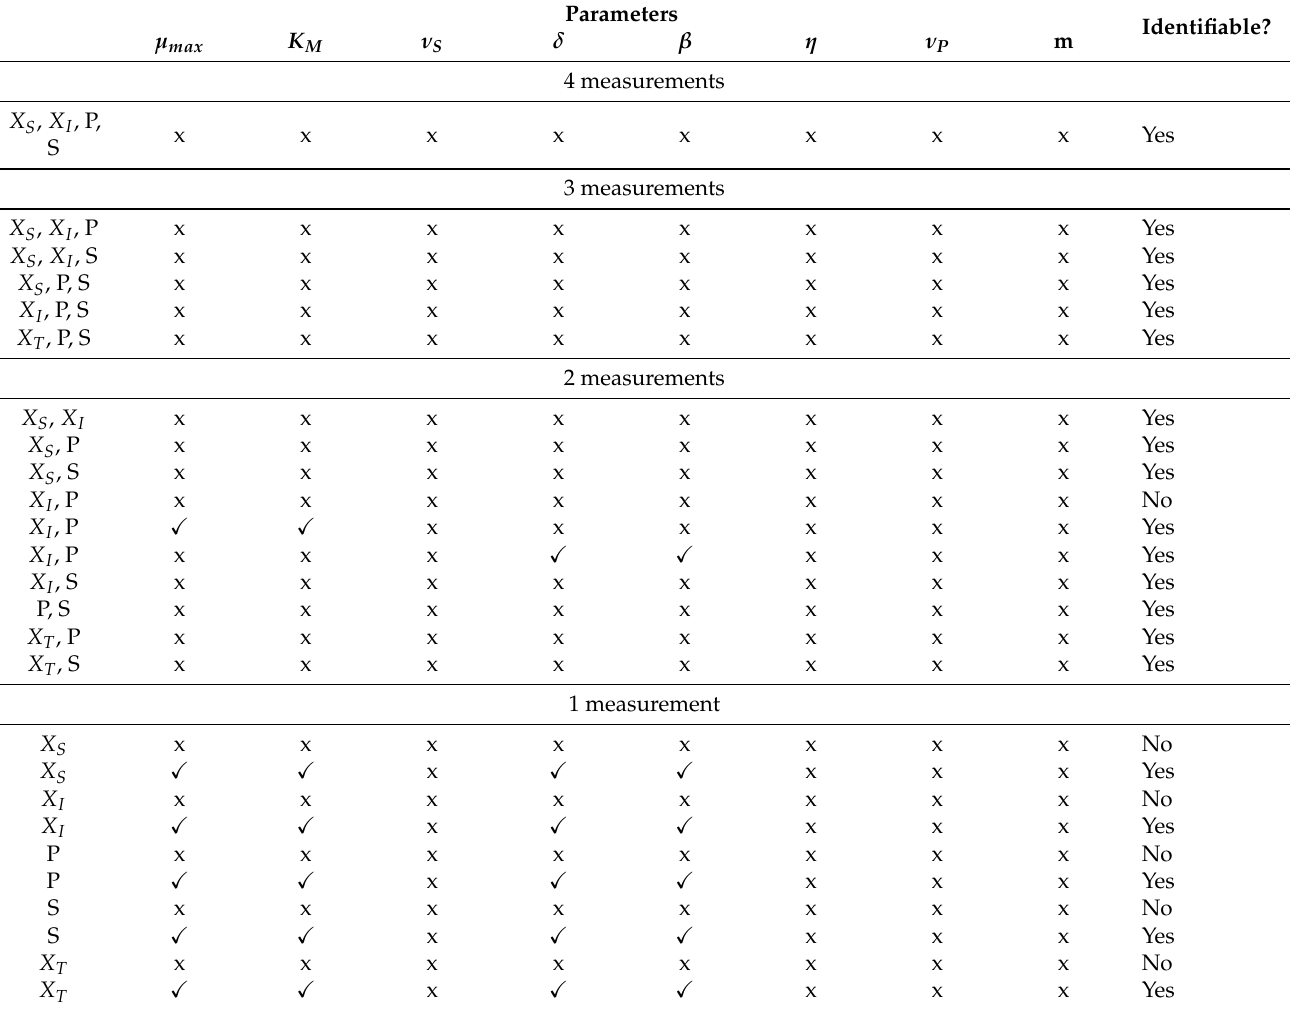
Table 3. Structural identifiability analysis with the STRIKE-GOLDD toolbox.